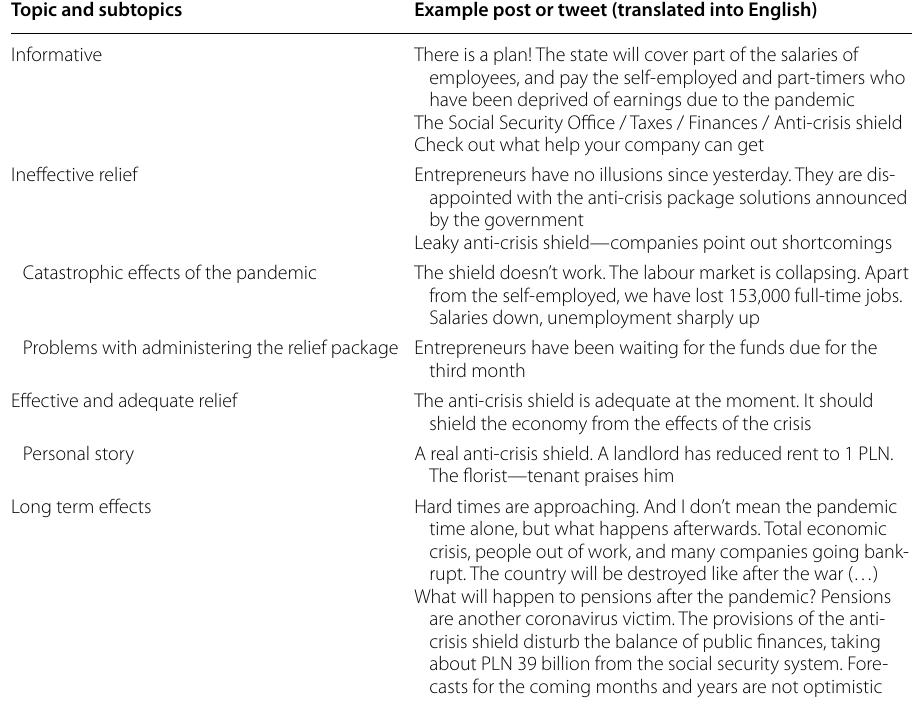
Table 1 Theme classification model Topic and subtopics Informative